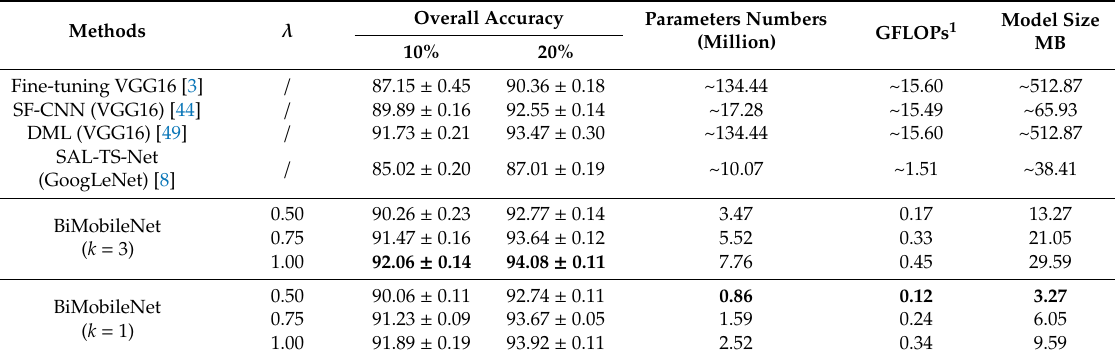
Table 7. Accuracy and complexity of state-of-the-art methods on NWPU-RESISC45 dataset. The highest accuracy and least calculation are